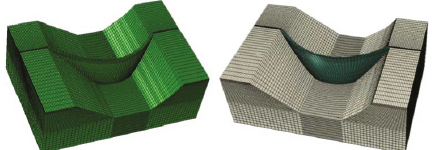
Figure 1: Finite element model of the arch